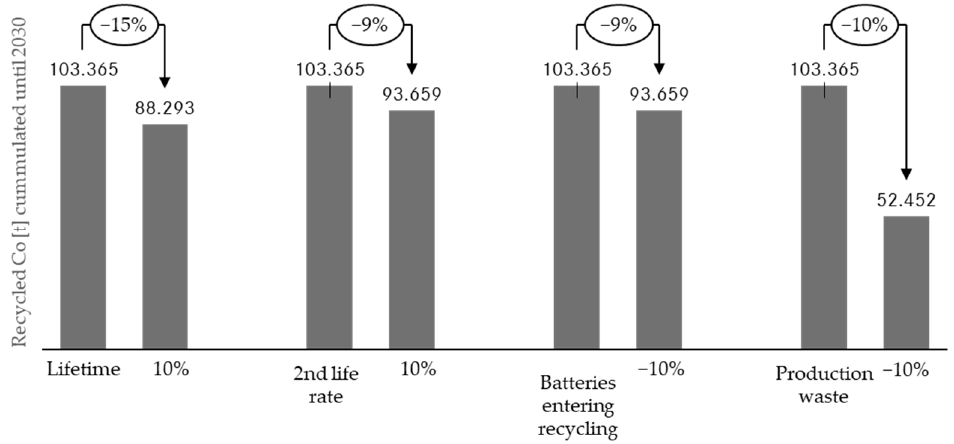
Figure 5. Sensitivity analysis to assess the impact of different parameters on the cumulated amount of recovered cobalt from battery recycling until 2030. of recovered cobalt from battery recycling until